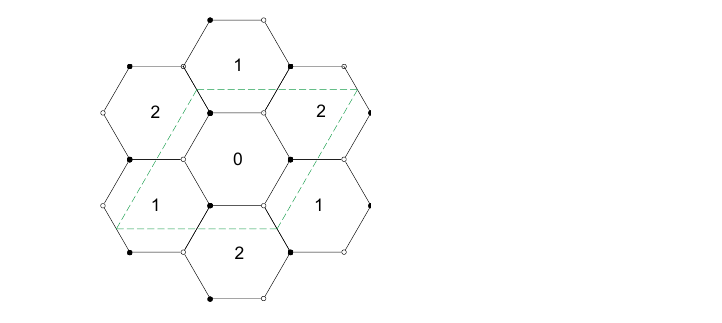
Figure 2. The dimer of the C 3 = Z 3 orbifold theory. The green dashed line de(cid:12)nes the fundamental